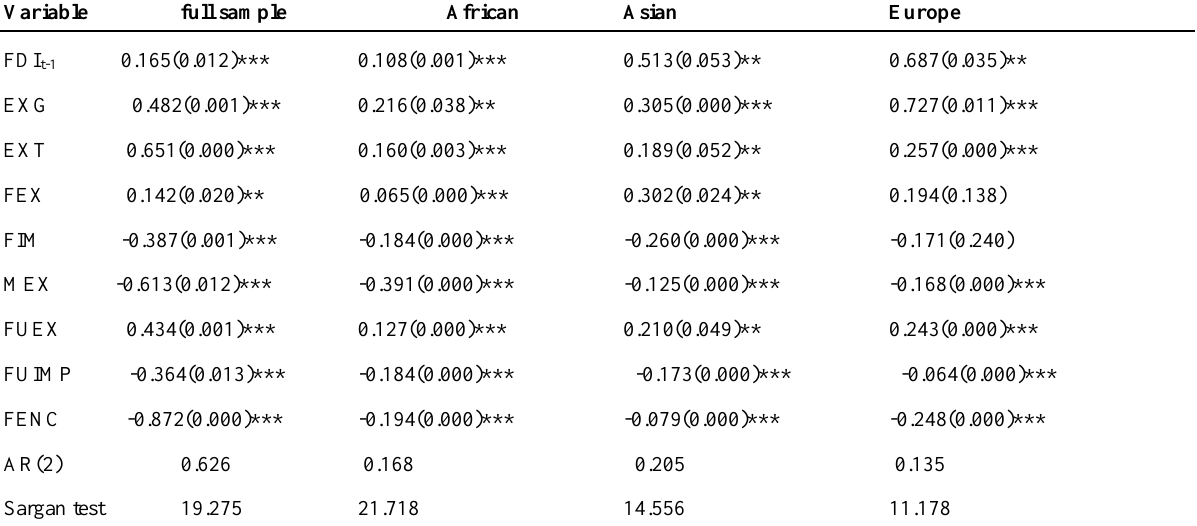
Table 2: GMM Results (Dependent Variable: FDI)